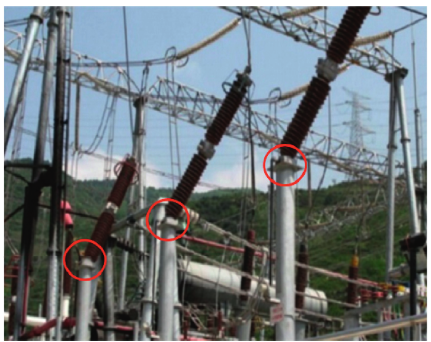
Figure 1: Failure of porcelain equipment after 2008 Wenchuan Earthquake [3].